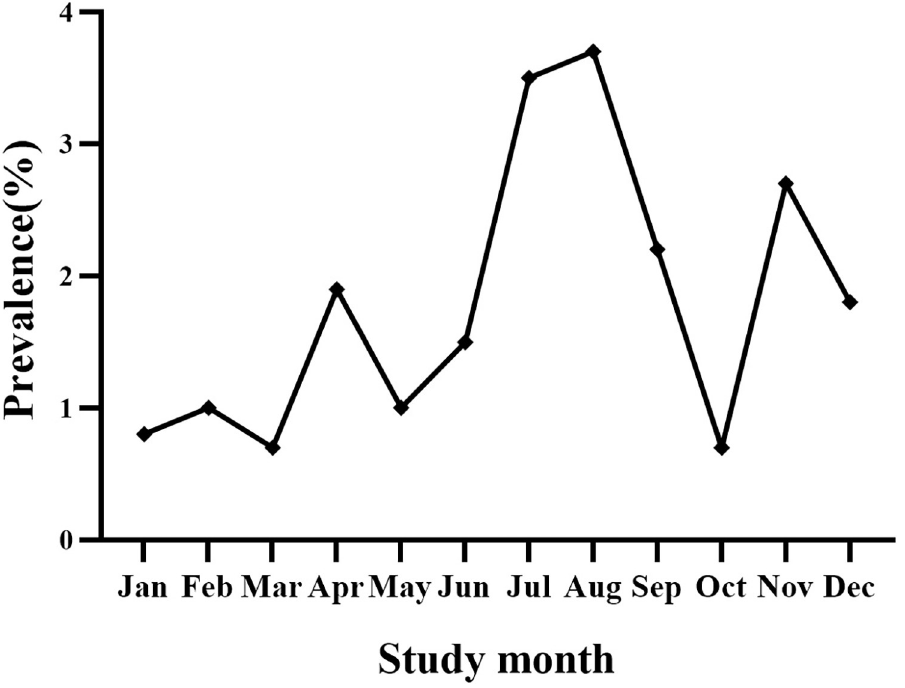
Fig 3. Monthly prevalence of acute gastrointestinal illness by month in the 4 weeks prior to interview in Zhejiang Province, southeast China, July 2018–June 2019.